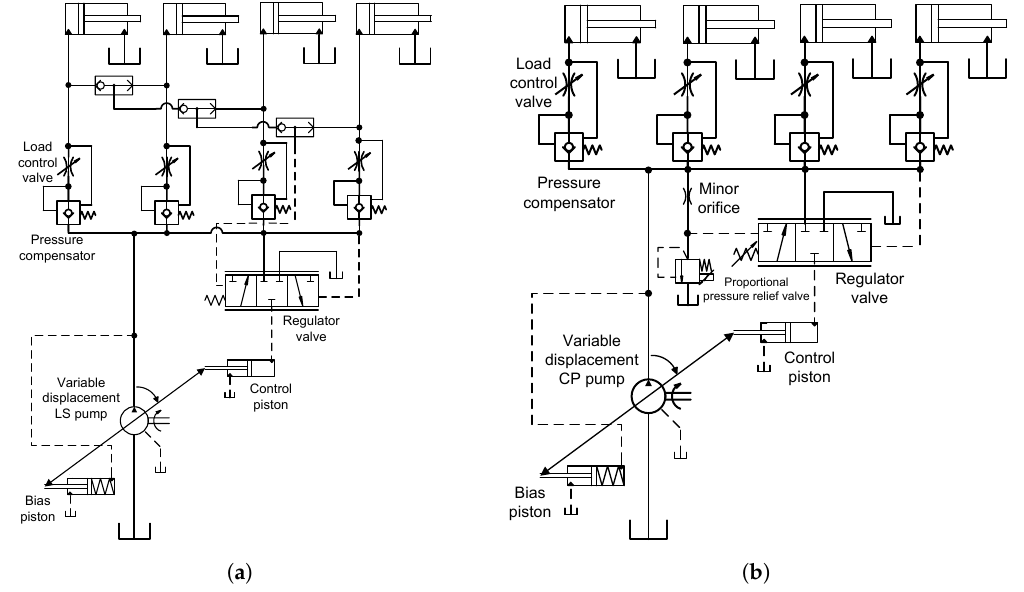
Figure 3. Hydraulic systems of the test-bed manipulator: ( a ) Conventional load-sensing system; and ( b ) electro-hydraulic constant-pressure